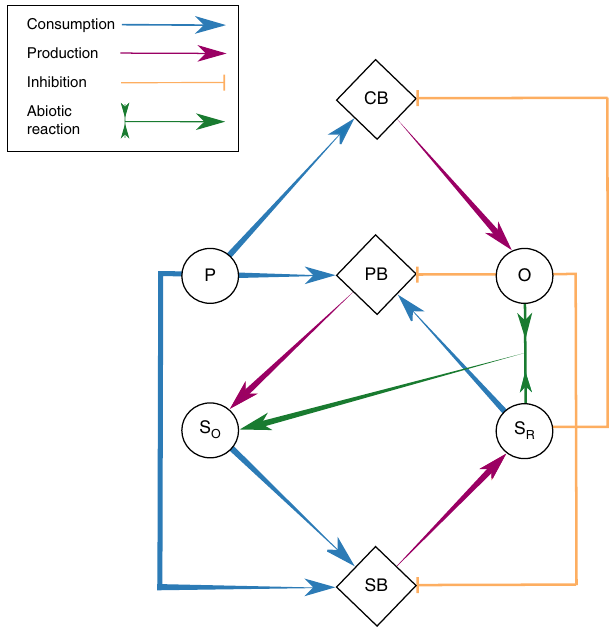
Fig. 1 Schematic diagram of the microbial ecosystem model. The model consists of three bacterial functional groups (CB cyanobacteria, PB phototrophic sulfur bacteria, SB sulfate-reducing bacteria) and four chemical substrates (P phosphorus, O oxygen, S R reduced sulfur, S O oxidized sulfur). Arrows denote the consumption ( blue arrows ) and production ( magenta arrows ) of chemicals by the microbial populations. Orange lines represent growth inhibition of the microbial populations. Green arrows indicate abiotic oxidation of reduced sulfur to oxidized